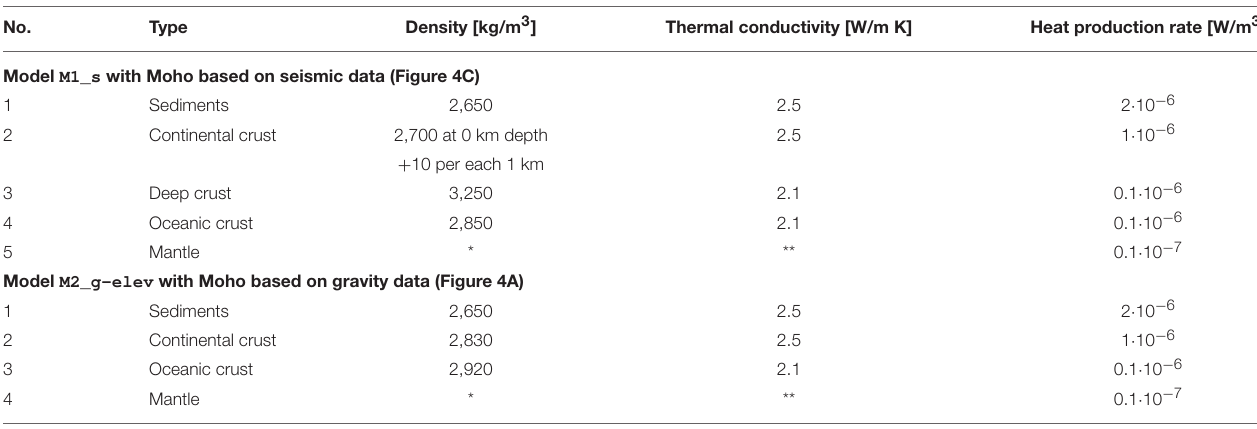
TABLE 2 | Geophysical parameters in our preferred